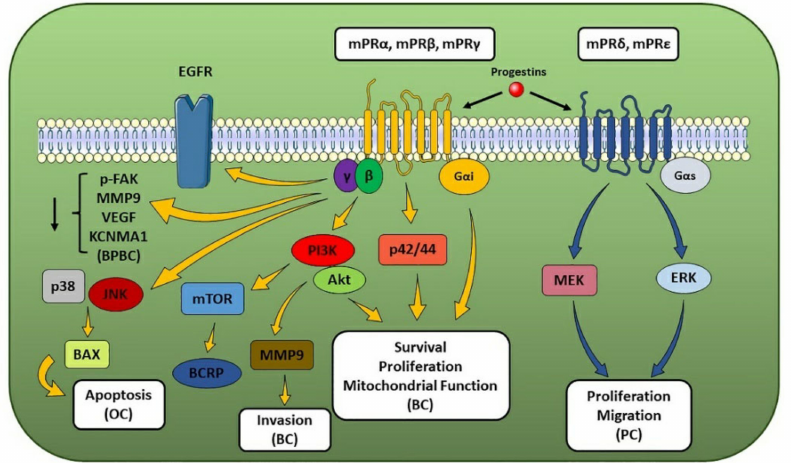
Figure 3. mPR-associated pathways and their effect on hormone-sensitive cancer progression. The figure illustrates the molecular pathways correlated to the different mPRs and their biological effects on multiple hormone-sensitive cancer types. When one or more tumor-related processes were reported only for a specific cancer type, the latter has been made explicit in the figure and put in parentheses (e.g., breast cancer as BC, prostate cancer as PC, ovarian cancer as OC, and basal phenotype breast cancer as BPBC) (see text for